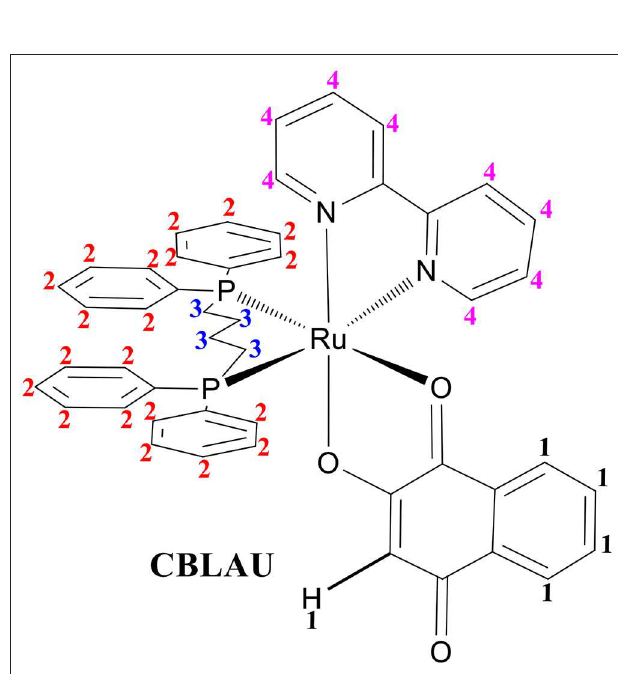
FIGURE 2 | Chemical structure for the Ru-complex (CBLAU) addressed in this work: the numbers 1 (black) correspond to the ligand lawsone; the number 2 (red) to aromatic protons of DPPB ligand; the number 3 (blue) to aliphatic hydrogens (butyl unit) between the two DPPB units and the number 4 (pink) to the hydrogens from the Bipy